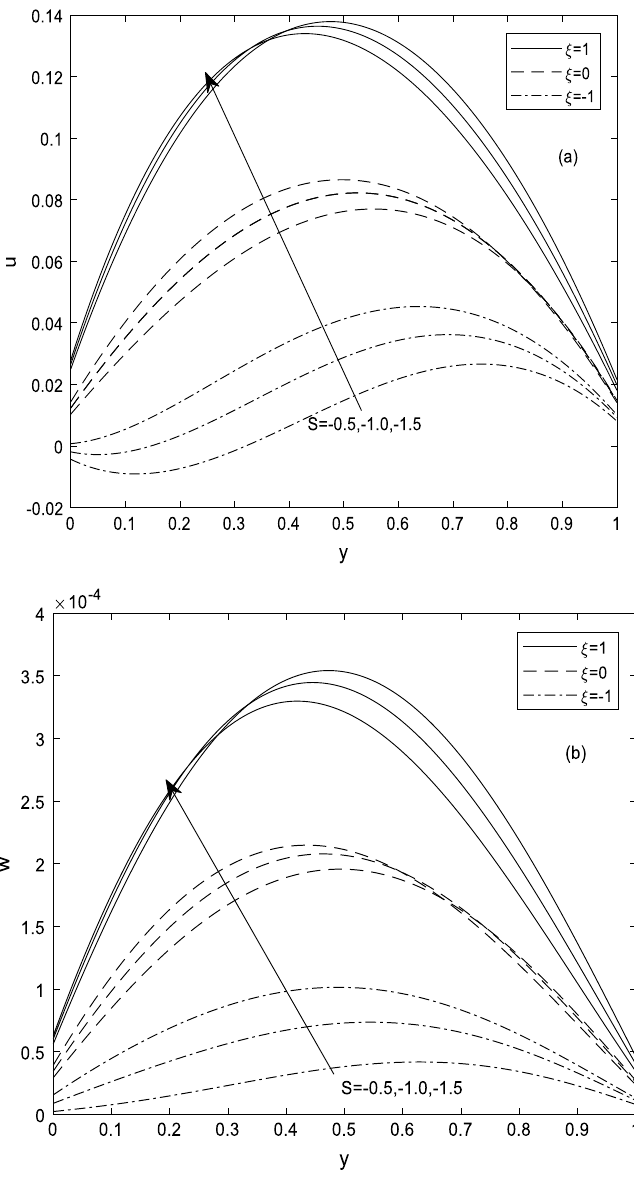
v Kn = 0.05, M = 2,ln = 1.667, β h = 0.10, β i = 3.0 and Pr = 0.71 . b Suction (negative value of S ) on the main flow and induced velocity profiles, for β